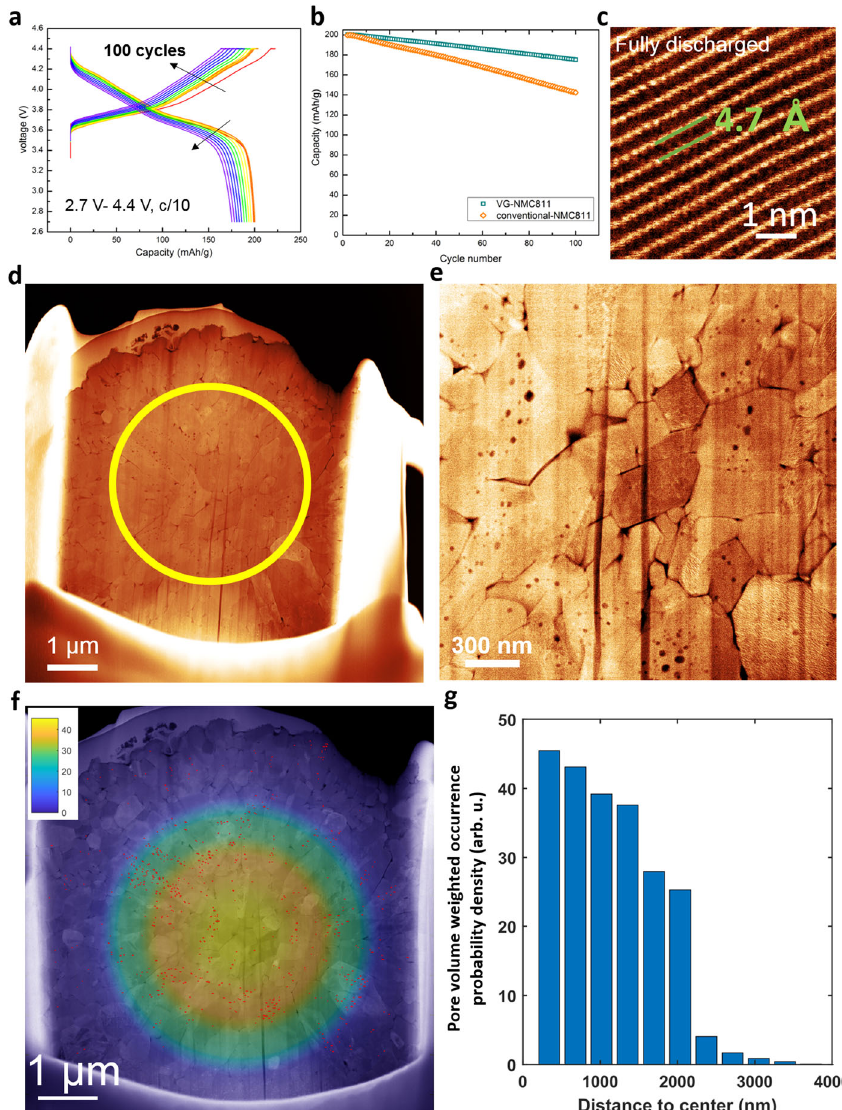
Fig. 2 Electrochemical characterization of valence gradient NMC811 material (VG-NMC811). a Charge/discharge curves of VG-NMC811//lithium half- cell with cut-off voltage of 2.7 and 4.4 V. b Comparison of charge capacity for 100 cycles between VG-NMC811 half-cell and conventional NMC811 half- cell. HAADF-STEM images of VG-811 NMC after 40 electrochemical cycles. c Atomic-resolution Z-contrast image shows well-retained layered structure with 4.7 Å lattice spacing between two transition metal layers. d Cross-sectional image of secondary particle showing higher density of nanopores in the central area. e Magni fi ed image of the central area of cycled secondary particle showing electrochemical cycling-induced nanopores. f The cross-sectional image with pore labels (red marks) and symmetrized pore volume density map overlaid. g The radially averaged pore volume weighted occurrence probability (see “ Methods ” for